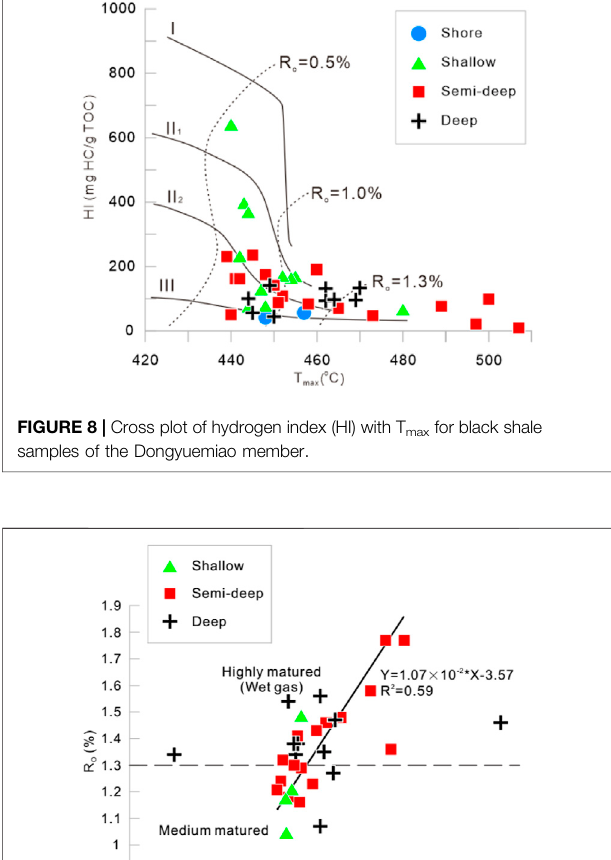
( Figure 5 ), which challenges the arti fi cial hydraulic fracturing by 1) the decrease of brittleness index and inhibition of open and propagation of hydraulic fractures (Tian et al., 2017) and 2) the interactions between clay